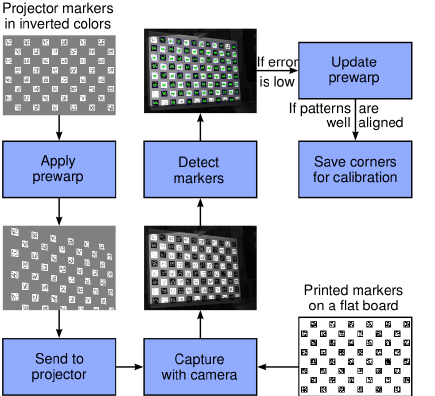
Figure 7. Diagram of the calibration procedure ( image credits [18])